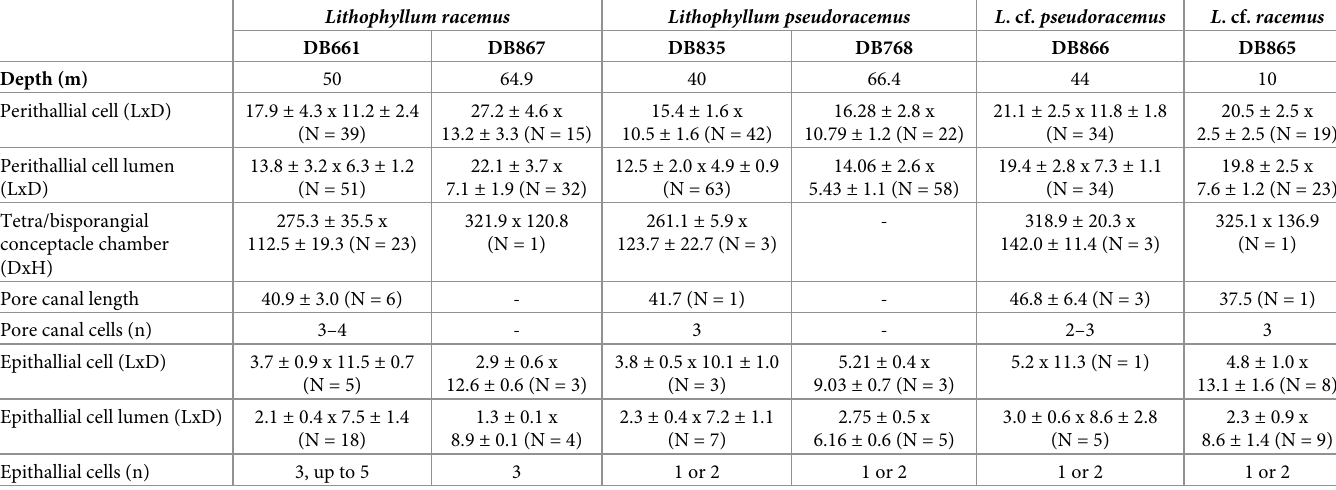
Table 2. Depth of sample collection and mean values ( ± SD) of biometrical traits from SEM image ( μ